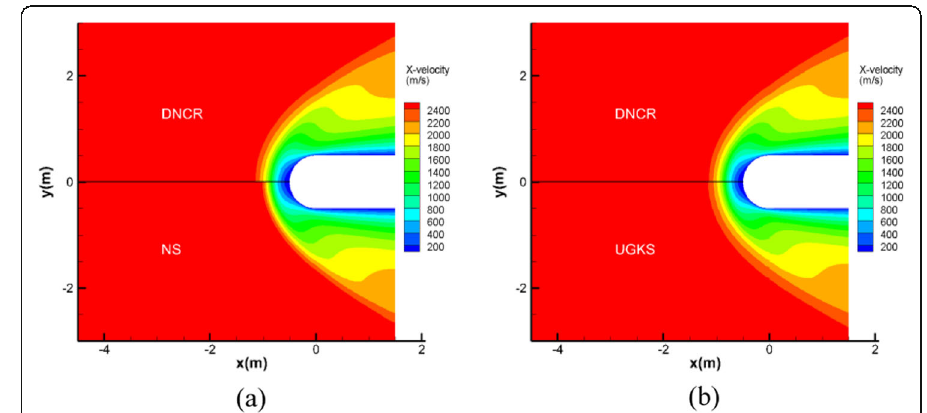
Fig. 9 X-velocity contours of DNCR and NS